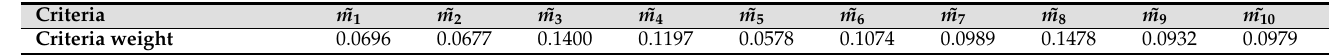
Table 16. Normalized criterion’s weight using neutrosophic AHP.